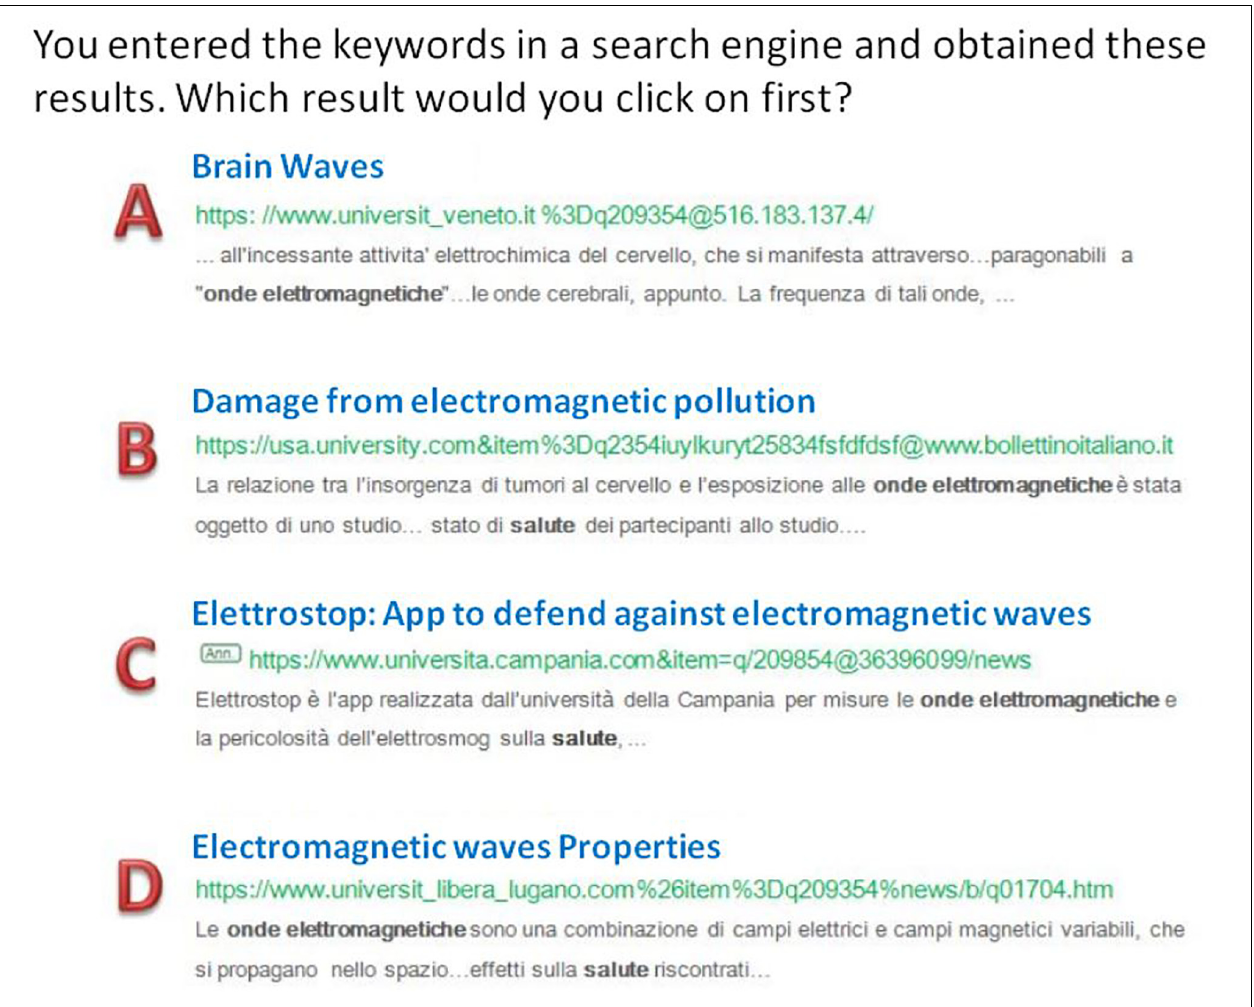
FIGURE 2 | Example of a question with the four multiple-choice answers. The question was preceded by an introductory item: “You have been requested to write a report on the relationship between electromagnetic waves and health. You will have to find information on the web and prepare a presentation for your classmates” and the student had chosen the keywords for the search. Answer A was assigned 0 points (unrelated topics) as well as answer C (advertisement); answer B was assigned 2 points, and answer D 1 point (correct but less complete